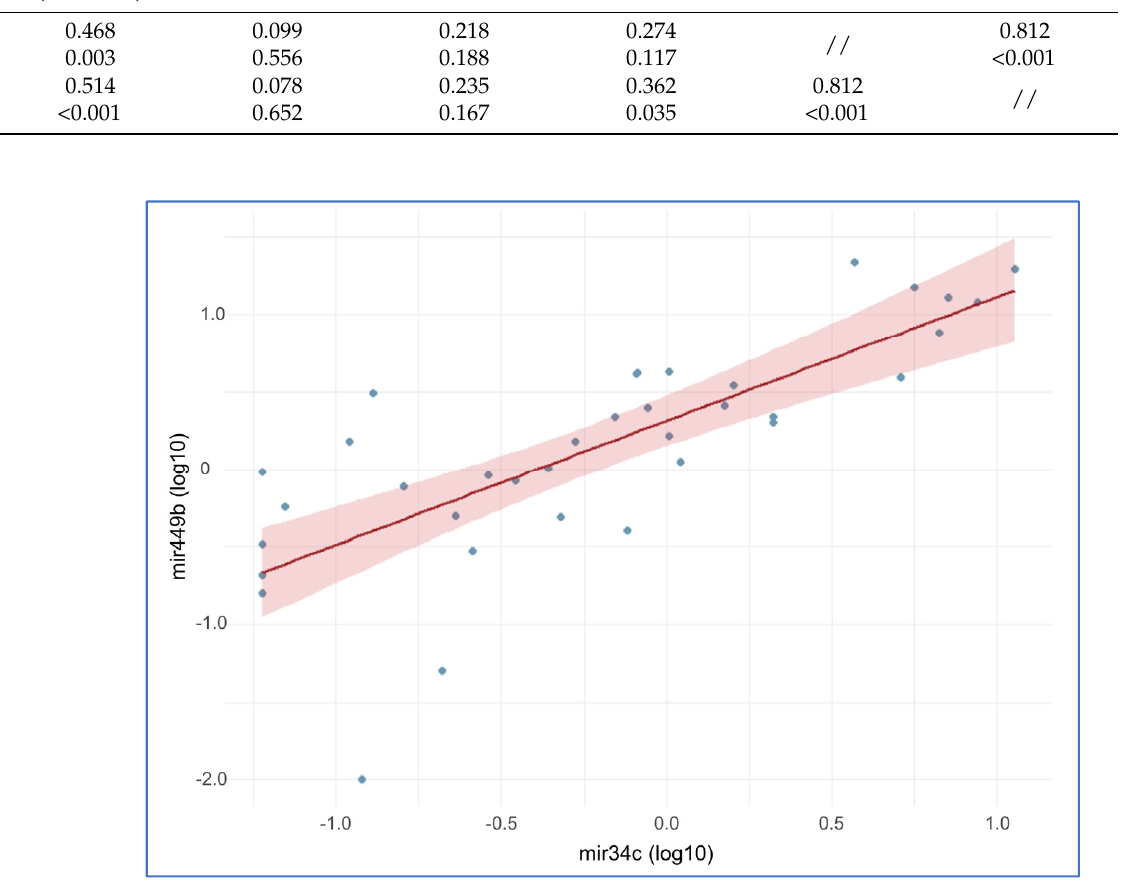
Figure 3. Correlation between the two miRNAs.